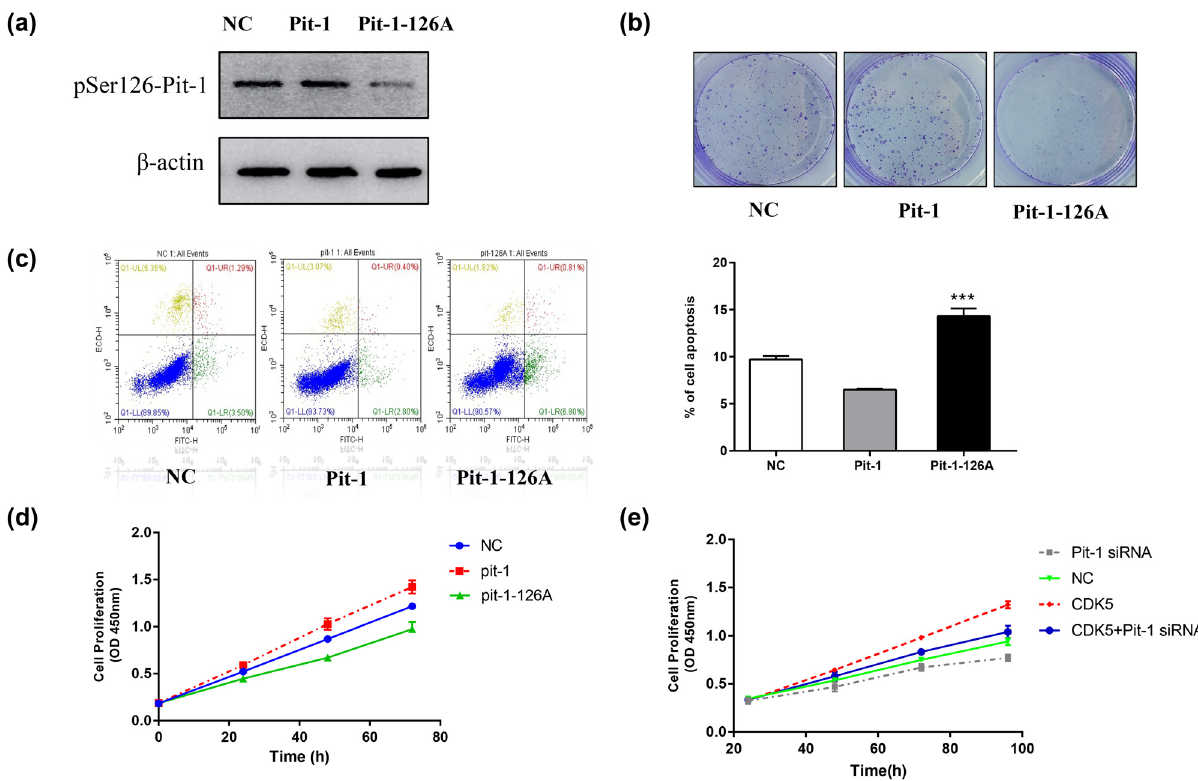
Figure 2: pSer126 - Pit - 1 promotes GH3 cell proliferation and suppresses apoptosis. ( a ) Western blot showed pSer126 - Pit - 1 in GH3 cell with WT - Pit - 1 or Pit - 1 - 126A. ( b ) The colony formation test shows that the percentage of colonies formed was reduced in the Pit - 1 - 126A groups compared with that of the Pit - 1 groups. ( c ) The apoptosis rates of the Pit - 1 - 126A groups were signi fi cantly higher than those of the Pit - 1 groups. ( d ) Higher cell viability was observed in the Pit - 1 groups. ( e ) The e ff ect of CDK5 could be reversed by Pit - 1 siRNA. **, P < 0.01; ***, P < 0.001. The bar represents the mean ±